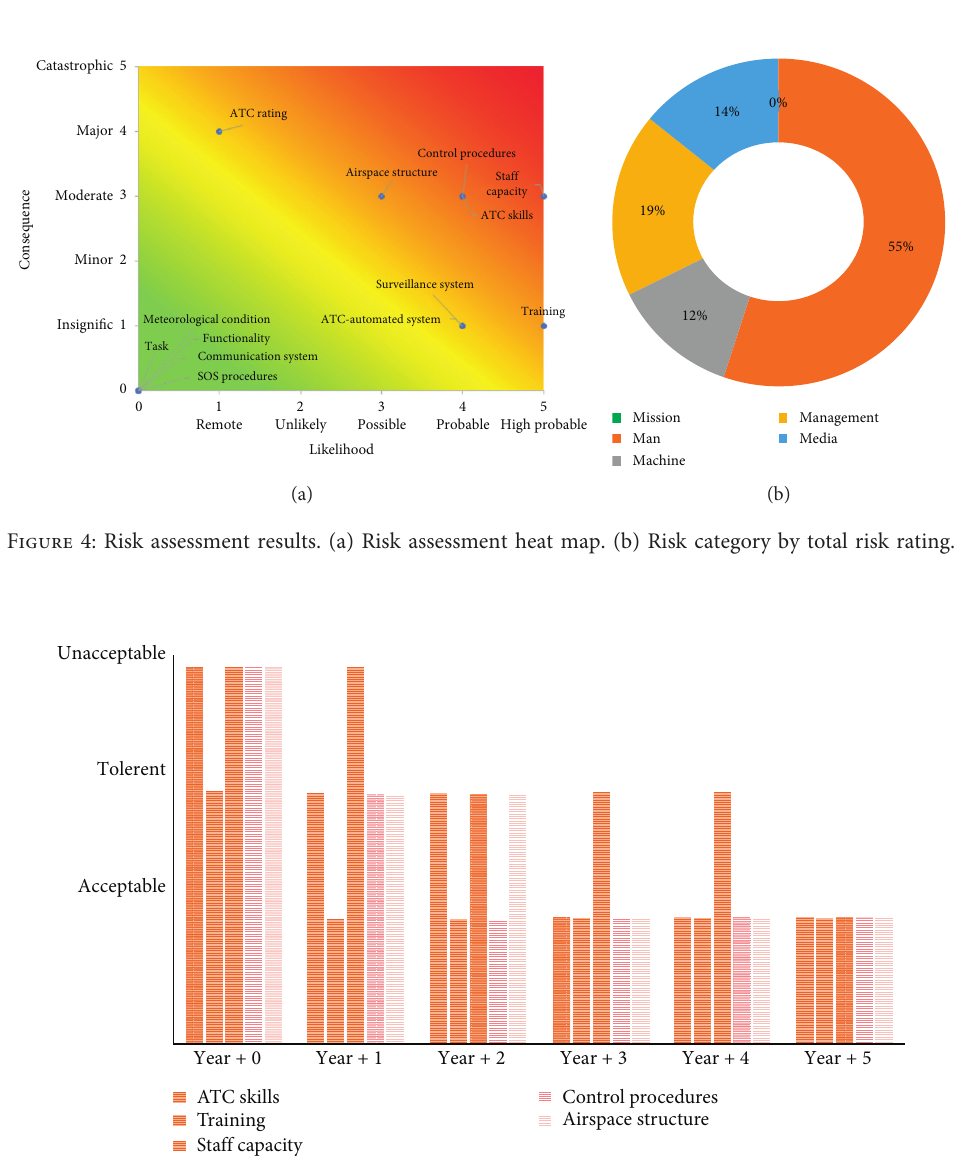
Figure 5: Risk control plan for next five